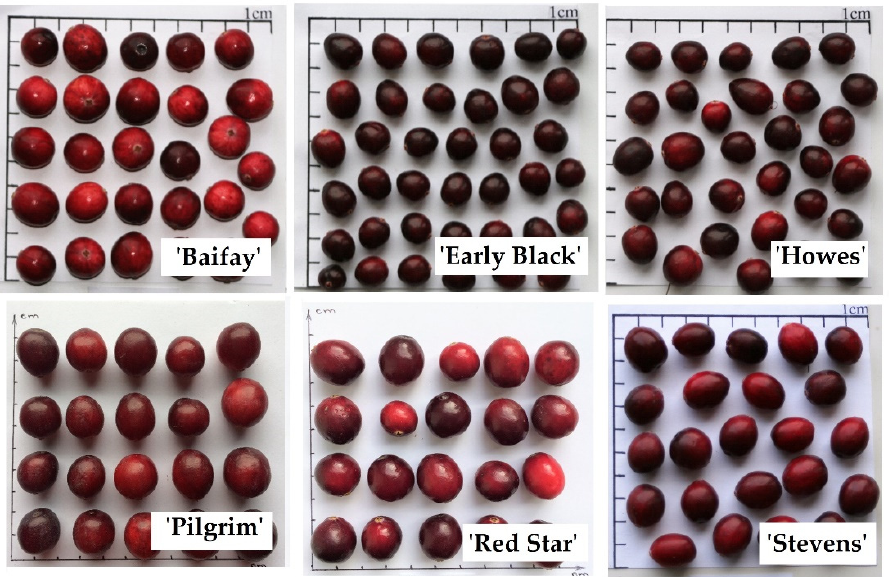
Figure 8. Variability of fruit sizes and shapes in large cranberry